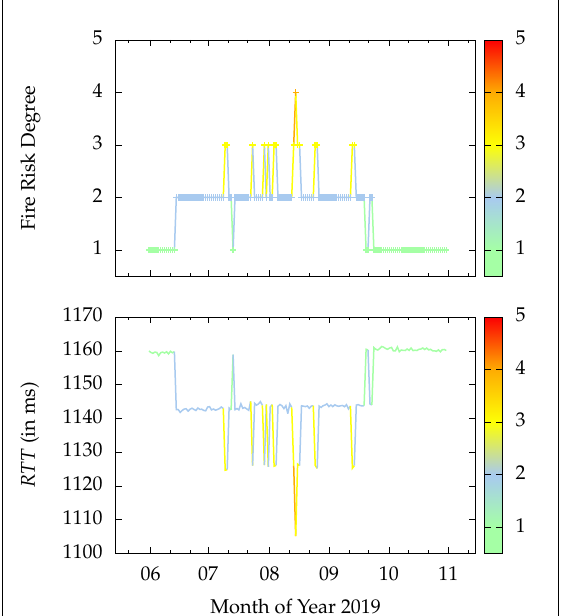
Figure 10. The fire risk degree (upper part) versus the average RTT in ms (bottom part), per day during the firefighting season of